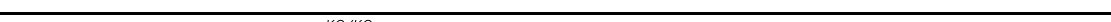
Fig. 2 BRE overexpression rescues Brca2 KO/KO cell viability without affecting BRCA2 function. a Ionizing radiation (IR)-induced RAD51 foci formation in Brca2 CKO/KO and Brca2 KO/KO ; MSCV-BRE ES cells. RAD51 foci are in turquoise, γ -H2AX foci in magenta, and nuclei are stained with 4,6-diamidino-2- phenylindole (DAPI, blue). Merged images show co-localization of RAD51 and γ -H2AX foci (yellow foci). b Quanti fi cation of RAD51 foci shown in a . Twenty- fi ve nuclei were counted for each genotype. Error bars represent the mean ± s.d. c Scatter plot showing DNA fi ber analysis of the indicated cell lines. P values were calculated using Mann – Whitney test. d Methylene blue-stained plates showing the sensitivity of Brca2 CKO/KO and Brca2 KO/KO ; MSCV- BRE ES cells to different doses of IR. e Quanti fi cation of the colonies shown in d . Colony numbers obtained in plates with no treatment (0 Gy) are considered as 100%. Average of three experiments is shown. Error bars represent s.d. values. f Representative metaphase spread showing chromosomal aberration (marked with arrows) in Brca2 CKO/KO and Brca2 KO/KO ; MSCV-BRE ES cells. g Quanti fi cation of different aberrations as well as total aberrations in 50 randomly selected Brca2 CKO/KO and Brca2 KO/KO ; MSCV-BRE metaphase